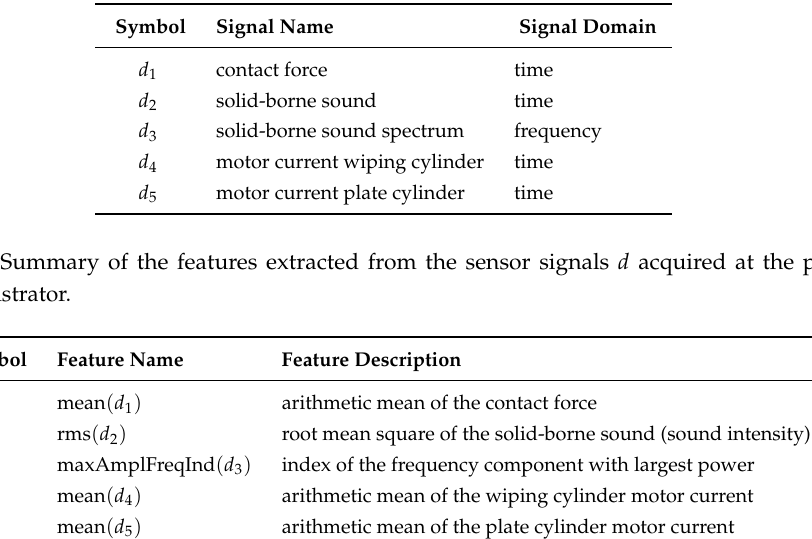
Table A1. Summary of the signals d acquired during printing unit demonstrator operation.